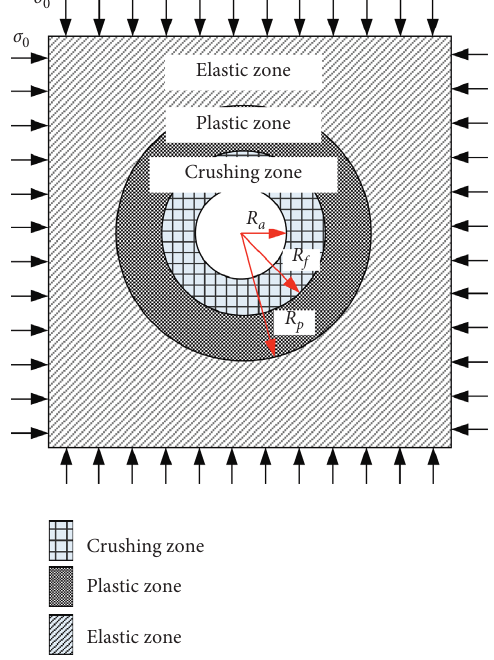
Figure 2: Zones in surrounding rock of roadway